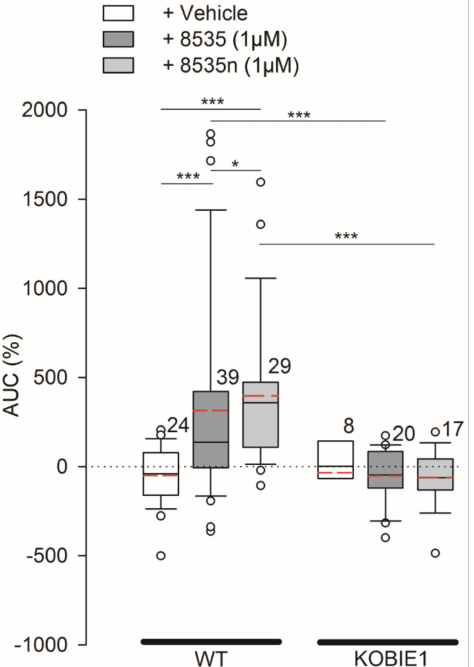
Figure 4. Comparison of responses in [lactate] i on stimulation with 1 µ M 8535 and 8535n, surrogate agonists of GPR27 in 3T3 cells. Comparison of the median area under the curve (AUC, %) of the Laconic FRET ratio signal on the addition of extracellular solution (vehicle, white boxes), GPR27 agonist 8535 (1 µ M; dark gray boxes), and GPR27 agonist 8535n (1 µ M; light gray boxes), in 3T3WT (WT) and 3T3KOGPR27 (KOBIE1) cells. For the difference between 8535 and 8535n (see Methods). Red dashed lines in boxes represent the average values, white circles are outliers. Note that the 8535n elicits larger AUC in 3T3 cells than 8535. Two-way and one-way ANOVA on ranks were used. Mann–Whitney rank sum tests were used for the comparison of isolated groups (* p ≤ 0.05, *** p ≤ 0.001). Numbers adjacent to boxes are the number of cells analyzed from at least three independent cell